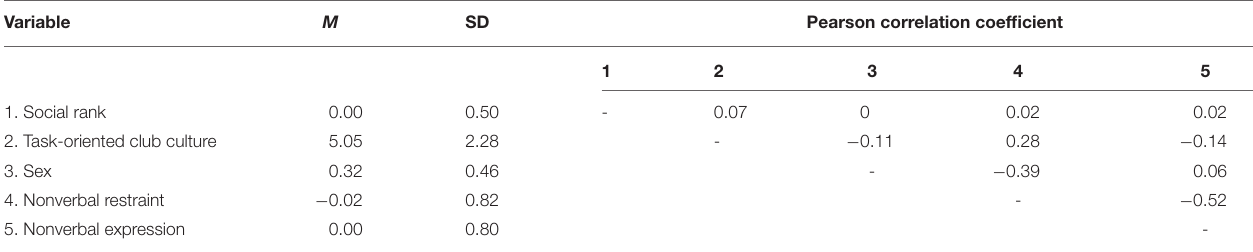
TABLE 4 | Descriptive statistics of variables used in hierarchical linear modeling.